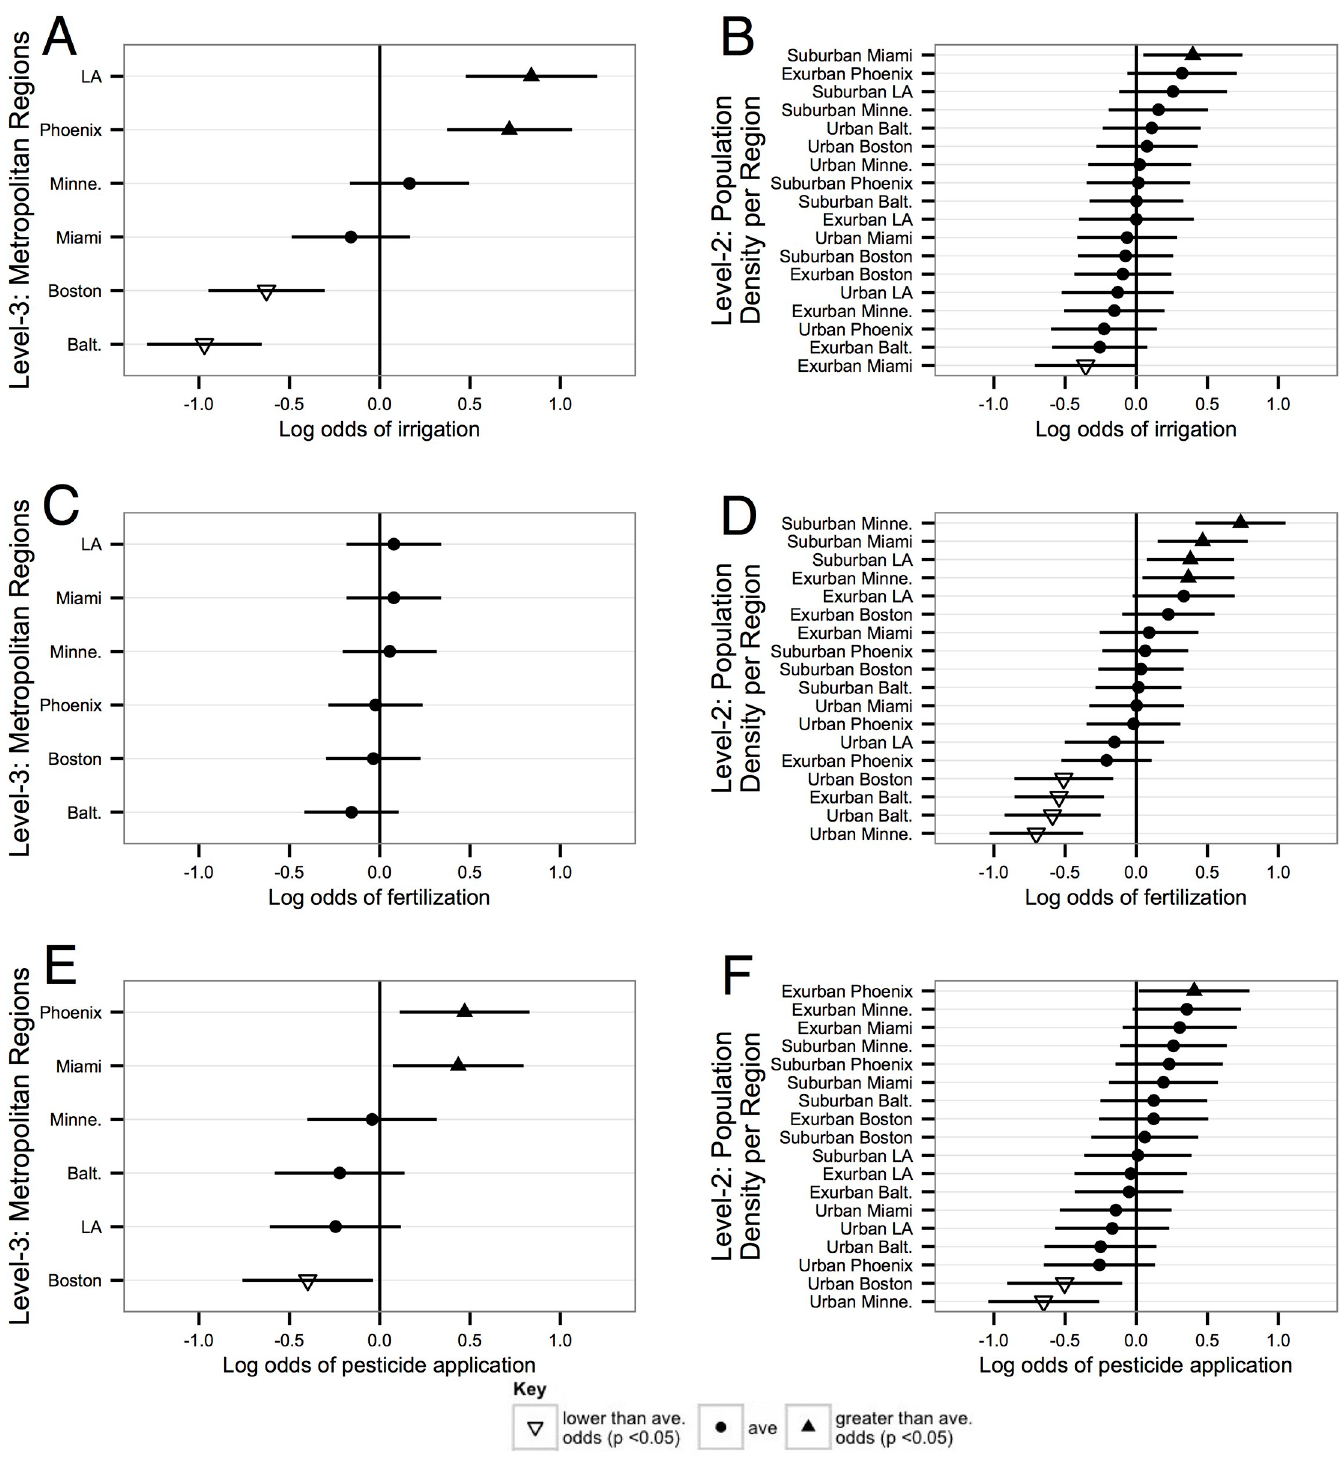
Fig 1. Dots and triangles represent the point estimates for the random effects for block group and metropolitan regions, v 00 lines are the 95% confidence intervals. When the interval crosses the mean (zero) the estimate is not significantly different from the mean, which is shown with dots. When there are significant differences below the mean, they are shown with downward-oriented triangles, while positive differences above the mean are shown with upward-facing triangles. Regions and region-population density combinations are arrayed according to their log odds (lowest on bottom, highest on top); note differences in y-axes across